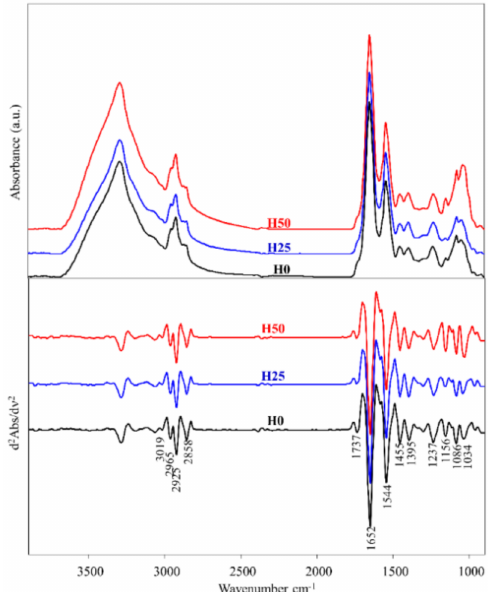
Figure 5. Average spectra of liver sections of rainbow trout fed the test diets: H0 (black), H25 (blue), and H50 (red). Spectra were reported in the 4000–900 cm − 1 spectral range in absorbance and second derivative modes (the wavenumbers of the most relevant peaks are reported in the bottom